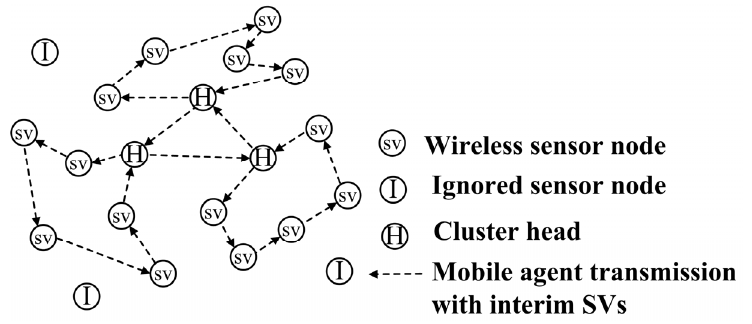
Figure 4. Computing scenario of collaborative hybrid learning